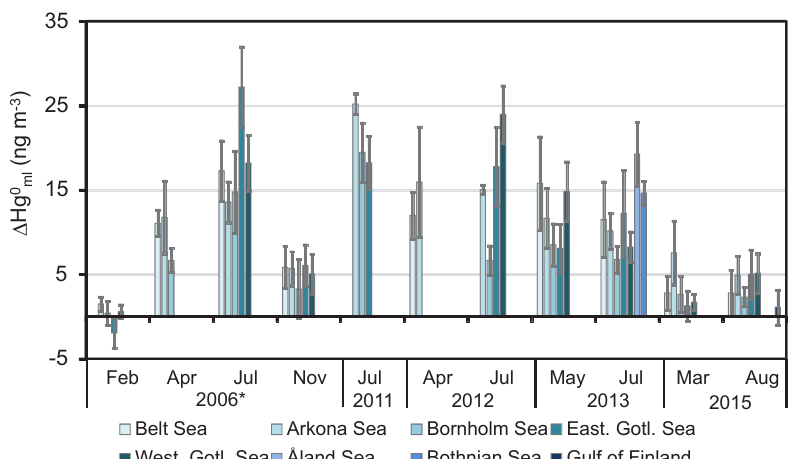
∗ Polynomial fit to Hg 0 atm data points versus time measured during the cruise.